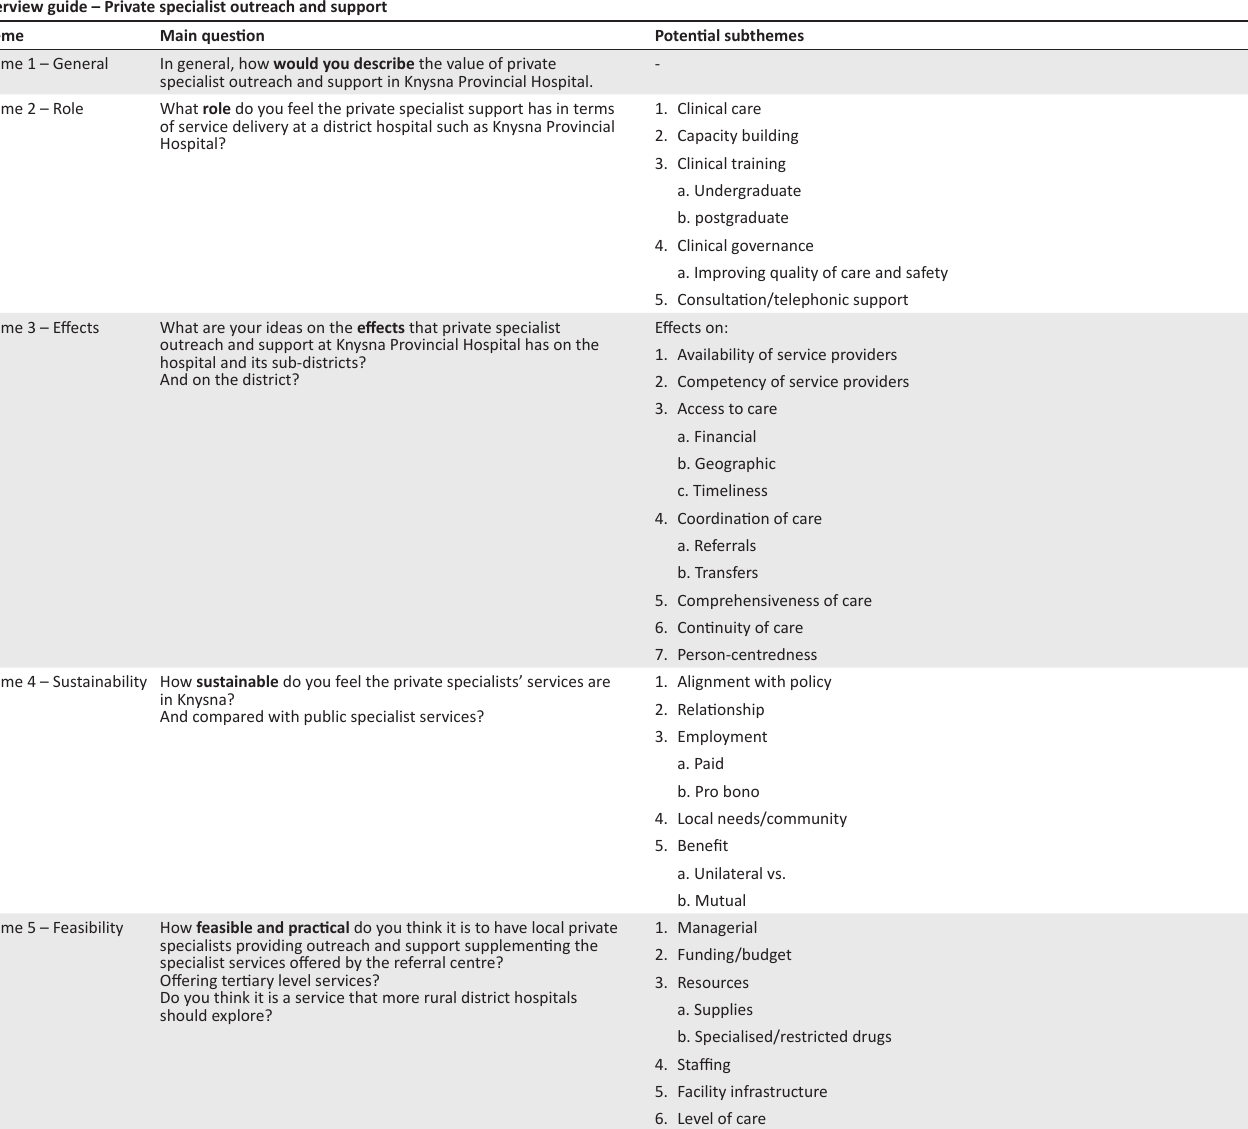
FIGURE 1-A1: Interview